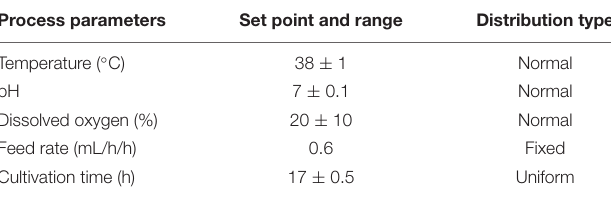
TABLE 6 | Process parameters and distributions for process